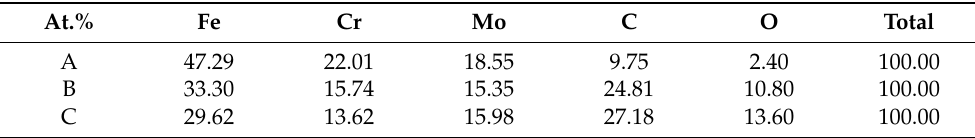
Figure 6. TEM images of coatings after annealing: ( a ) initial coating, ( b ) after annealing at 600 °C, ( c ) after annealing at 700 °C. ( d ) SAED image of coating after annealing at 700 °C. ( e , f ) Magnification photos of coating after annealing at 700 °C. Table 5. Chemical composition analysis of coating after annealing at 700 °C using TEM-EDS ( in red circled area ).